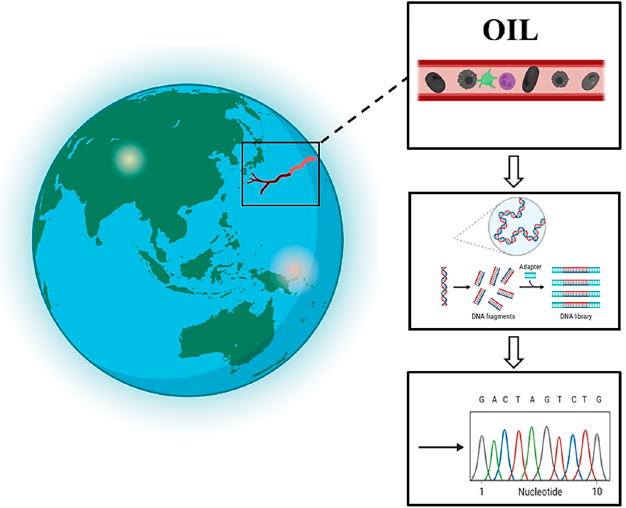
Figure 1. Significance of DNA sequencing of petroleum-based microorganisms.